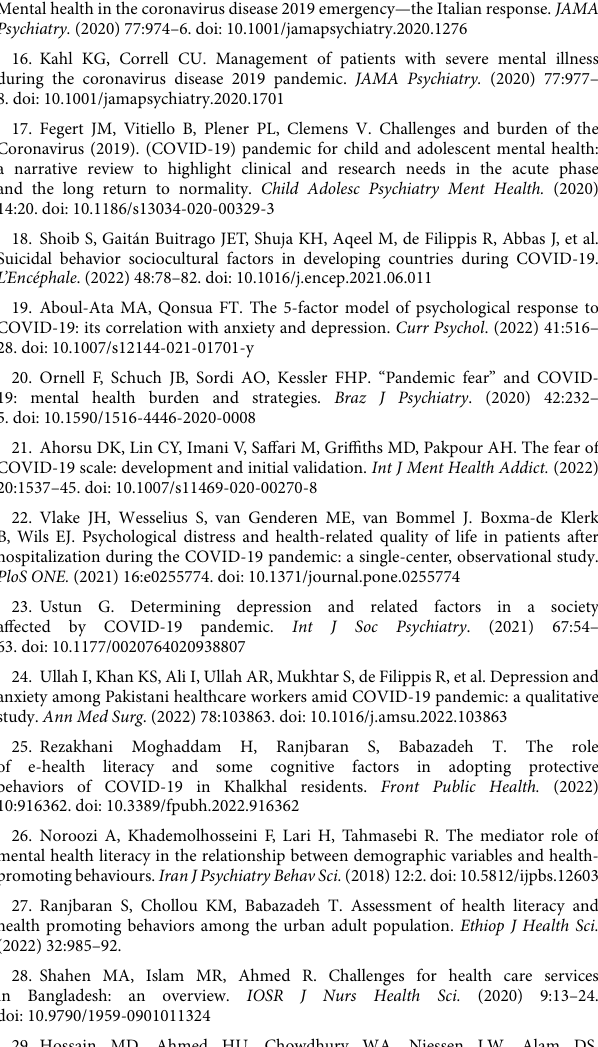
SUPPLEMENTARYTABLE1 Proportional comparison of respondents’ background characteristics and number of mental health-related symptoms ( N =